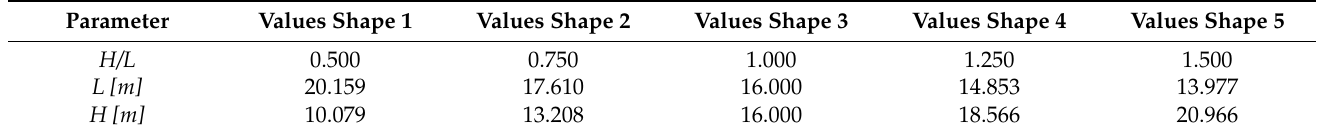
Table 14. Dimensions of the cages for studying the effect of cave dimensions ratio at constant cage volume 4096 m 3 .